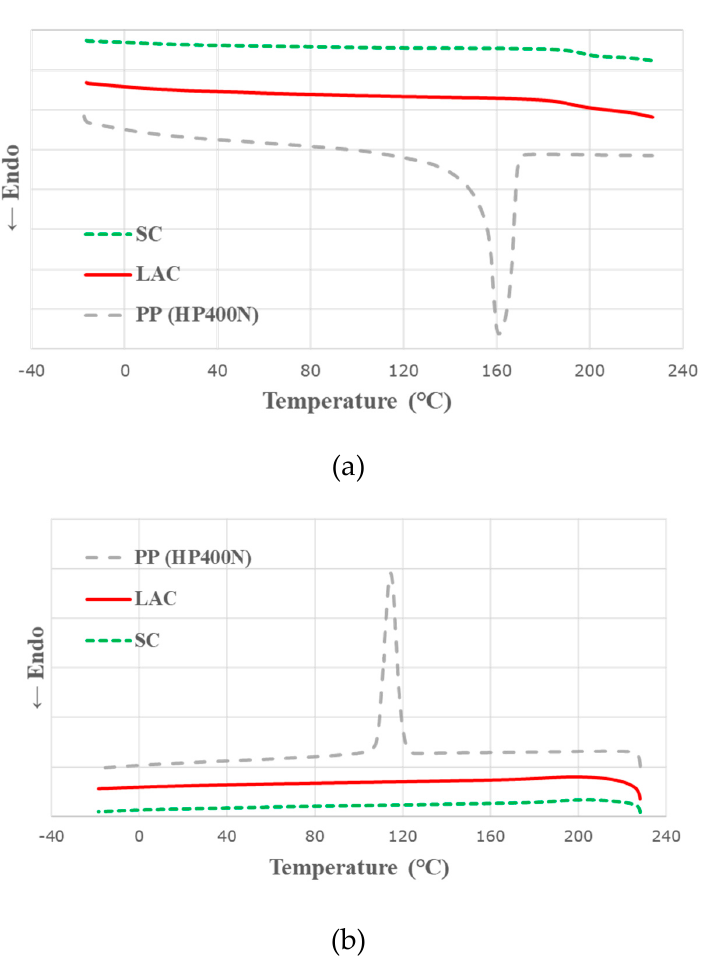
Figure 1. The heating ( a ) and cooling ( b ) curves of neat PP, lactic casein (LAC), and sodium casein (SC) samples.